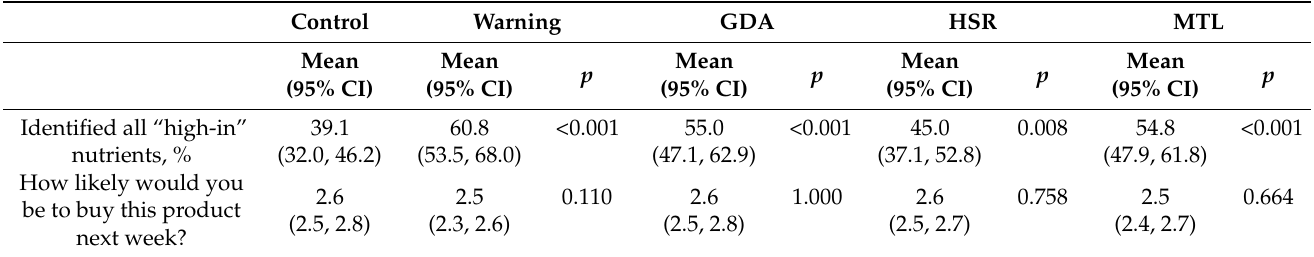
Table A6. Results for primary outcome by label arm ( n = 14,345).